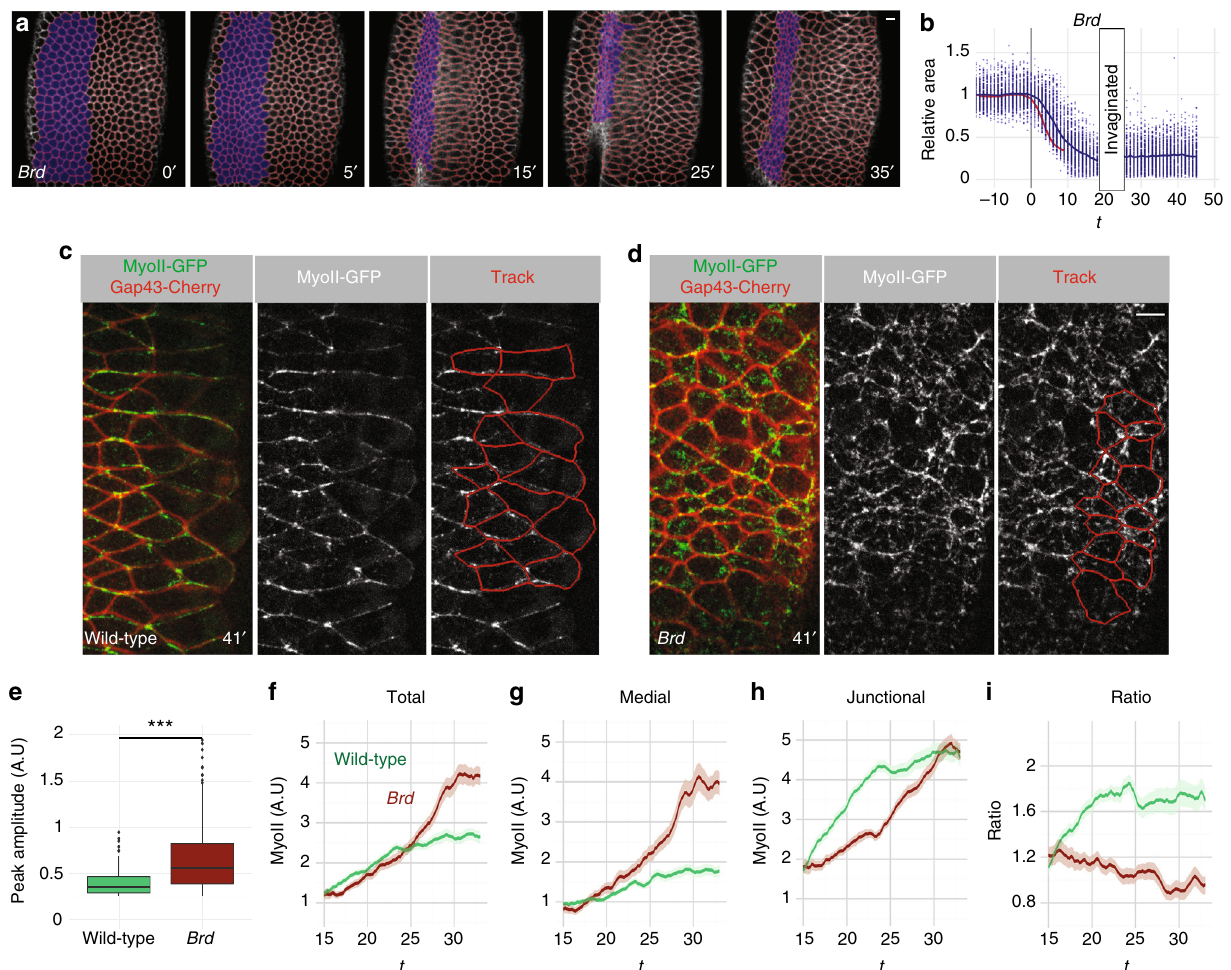
Fig. 5 Furrow unfolding in Brd mutants. a , b Live imaging of a Brd -mutant embryo a expressing MyoII-GFP (not shown) and Gap43-Cherry (white; tracking in red). The furrow initially formed then regressed. Apical constriction ( b , surface area values plotted as in Fig. 1f) was slightly slower in Brd mutants relative to wild-type (red curve). Once invaginated, ventral cells could no longer be tracked ( b ); they were tracked again after furrow unfolding. c , d Live imaging of MyoII-GFP (green) and Gap43-Cherry (red) in the ectoderm of wild-type ( c ) and Brd mutant ( d ) embryos. MyoII localized at junctions to form supracellular cables along the DV axis in wild-type embryos (ventral furrow, right). A medial – apical pool of MyoII could also be detected. Increased MyoII levels were detected at the medial – apical cortex in the ectodermal cells of Brd -mutant embryos ( d ). e Box plots of the amplitude values of the MyoII pulses measured at the medial – apical cortex of wild-type ( n = 144 pulses measured in 50 cells from three embryos over a 24 min period) and Brd -mutant embryos ( n = 350; 50 cells from three embryos over a 26.6 min period). MyoII levels were measured in lateral ectoderm cells (see tracking in c , d ). Higher amplitude values levels were measured in Brd mutants ( p < 10 − 15 ), showing that loss of Brd dramatically increased the level of MyoII contributing to assembly – disassembly pulses in the ectoderm. f – i Higher total and medial MyoII levels were measured in the ectoderm of Brd -mutant embryos ( f , g ; n = 3) relative to control embryos ( n = 3). MyoII was mostly junctional in wild-type embryos ( h , i